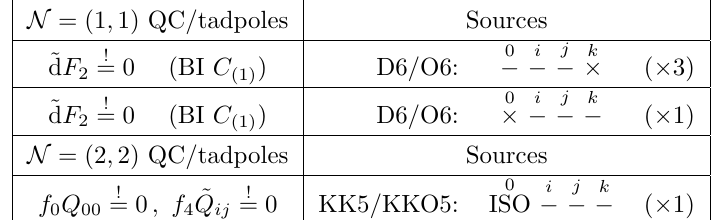
Table 11 . Non-vanishing QC (3.6), (3.8) and their higher-dimensional origin for the (cid:13)ux compact- i(cid:12)cation of type mIIA with KKO5/KK5 given in table 9, where BI stands for Bianchi identities and ~d (cid:17) d + ! ^ . A description of the QC as restrictions for the existence of additional local sources is